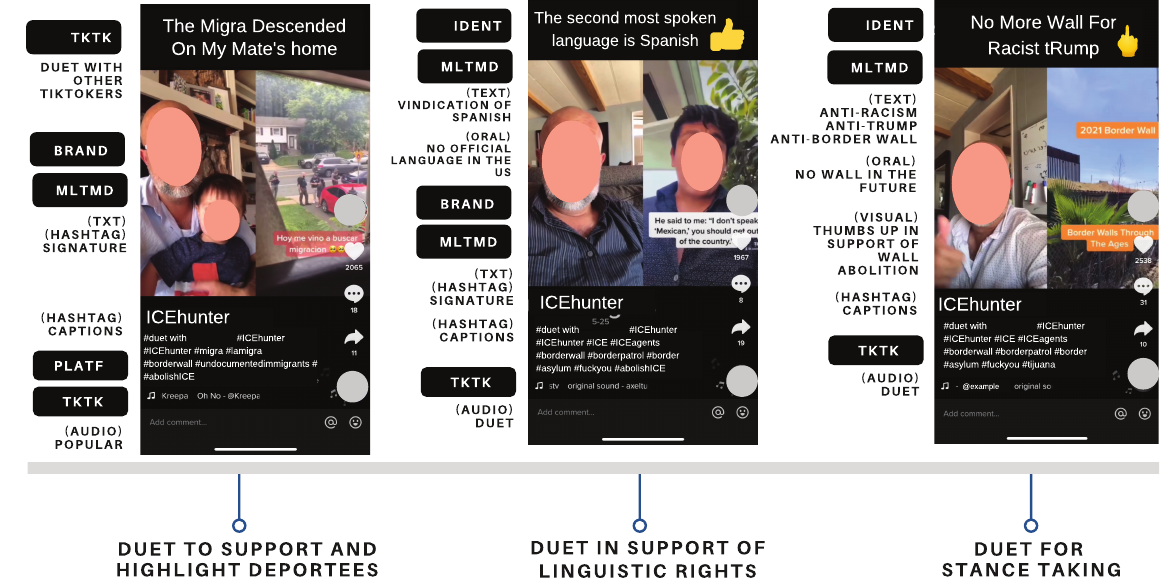
Figure 4. ICEhunter’s use of the duet function, multimodal elements, and TikTok configurations. Media and Communication, 2022, Volume 10, Issue 1, Pages